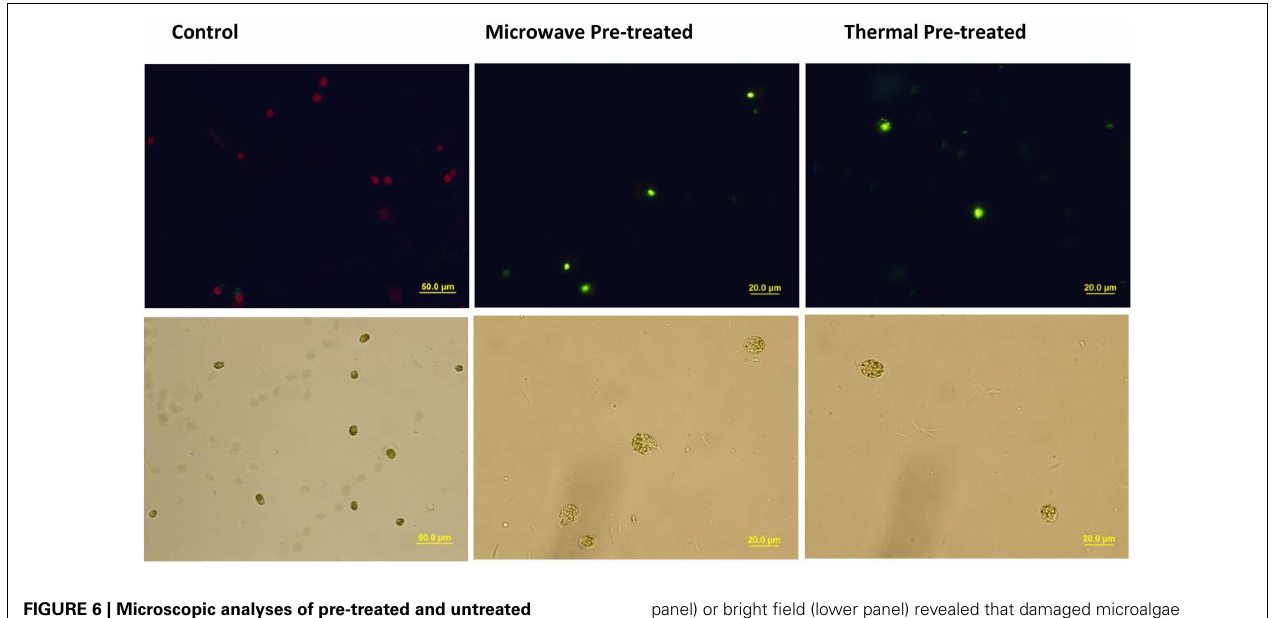
FIGURE 6 | Microscopic analyses of pre-treated and untreated control Tetraselmis sp. M8 cells obtained from microalgal slurry . SYTOX green-stained cells observed under fluorescent field (upper